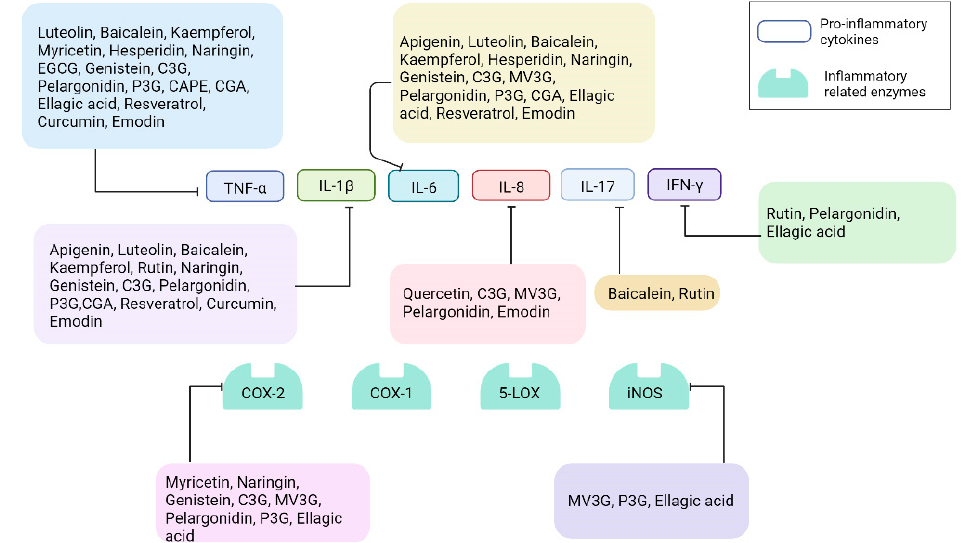
Figure 3. The regulatory inflammatory responses by which polyphenols affect the TLR4-mediated signaling pathway. EGCG, epigallocatechin-3-gallate; C3G, cyanidin-3-glucoside; MV3G, malvidin 3-glucoside; P3G, pelargonidin-3-O-glucoside; CAPE, caffeic acid phenethyl ester; CGA, chlorogenic acid. Inhibition.